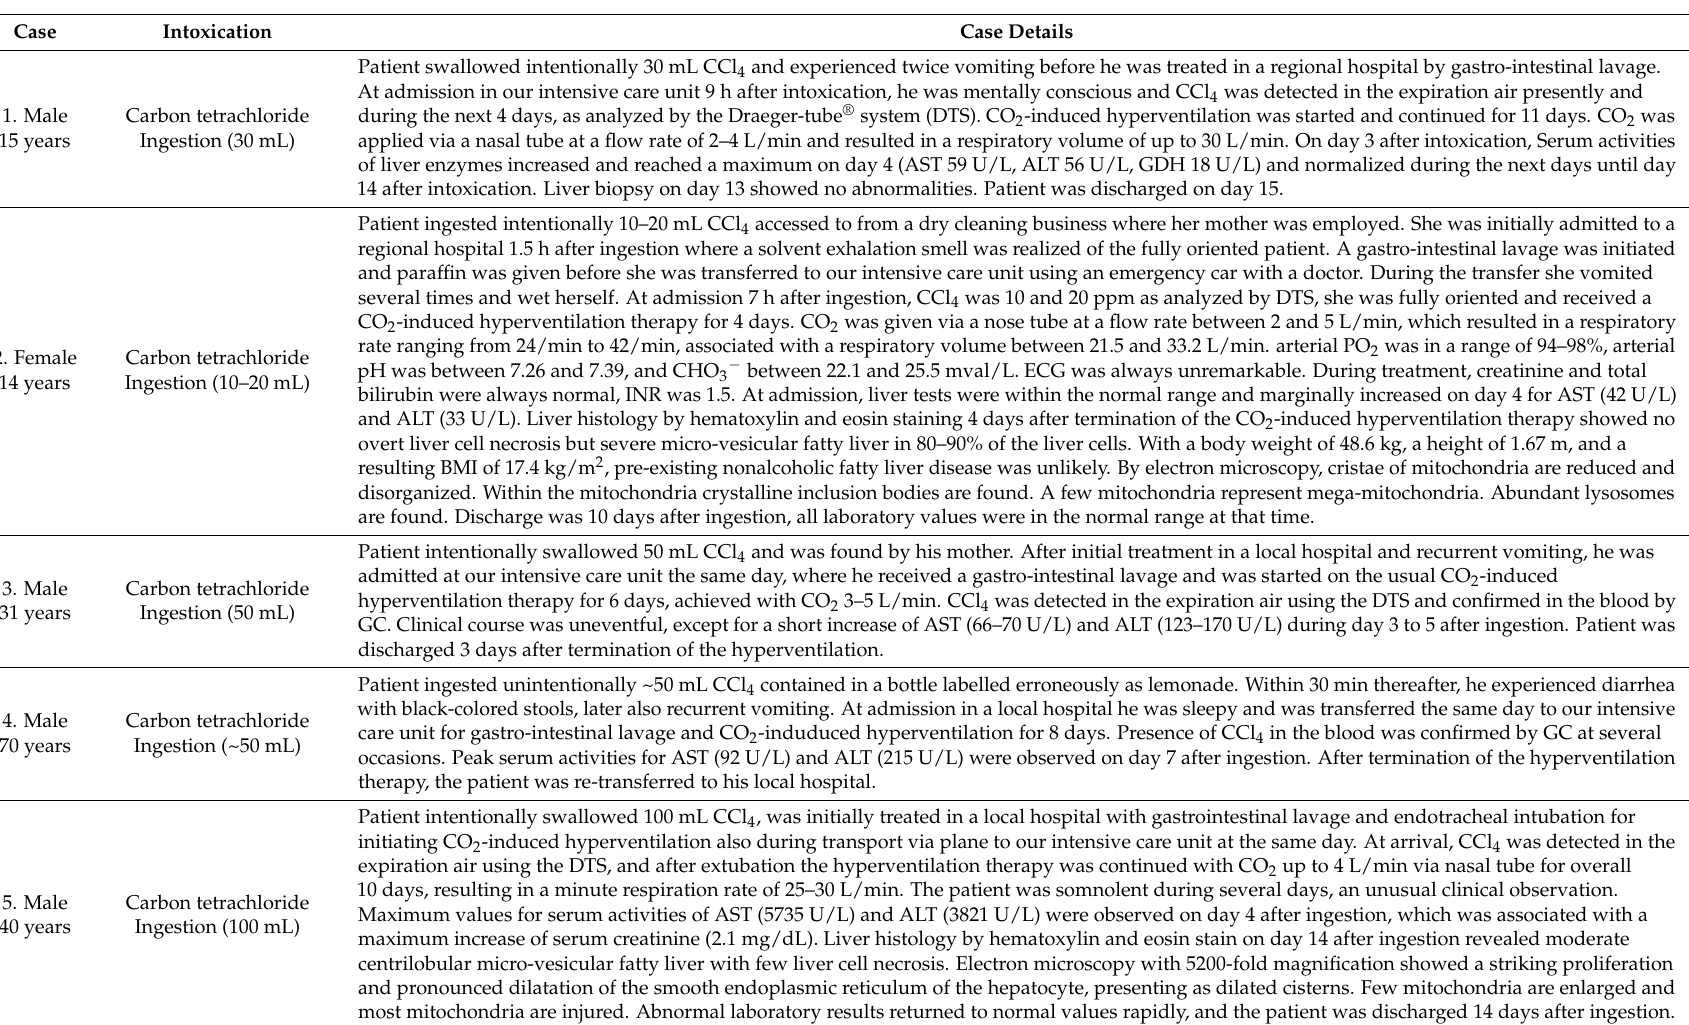
Table 7. Clinical details of 16 patients with acute CCl 4 intoxication treated with the CO 2 -induced